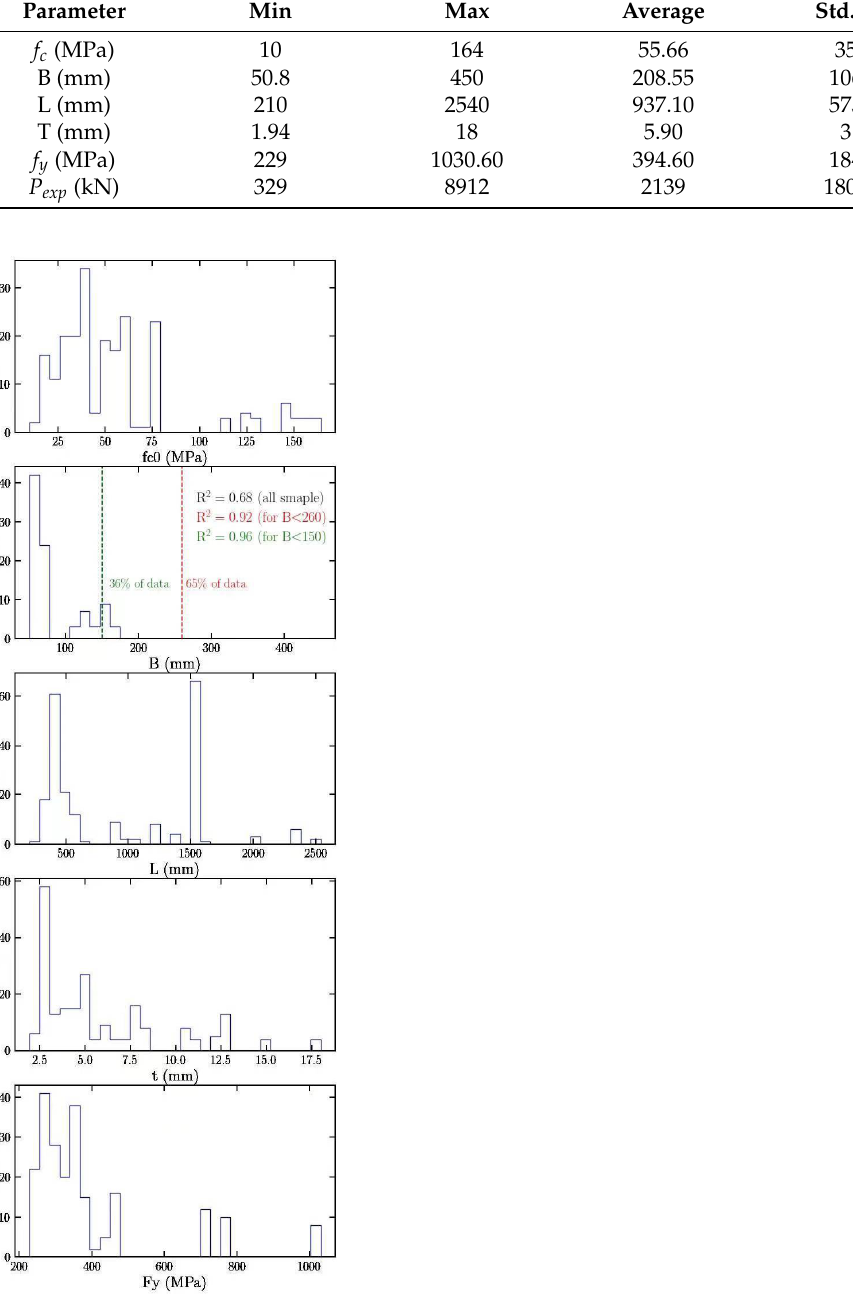
Figure 7. Statistical distribution of the first patch of data.